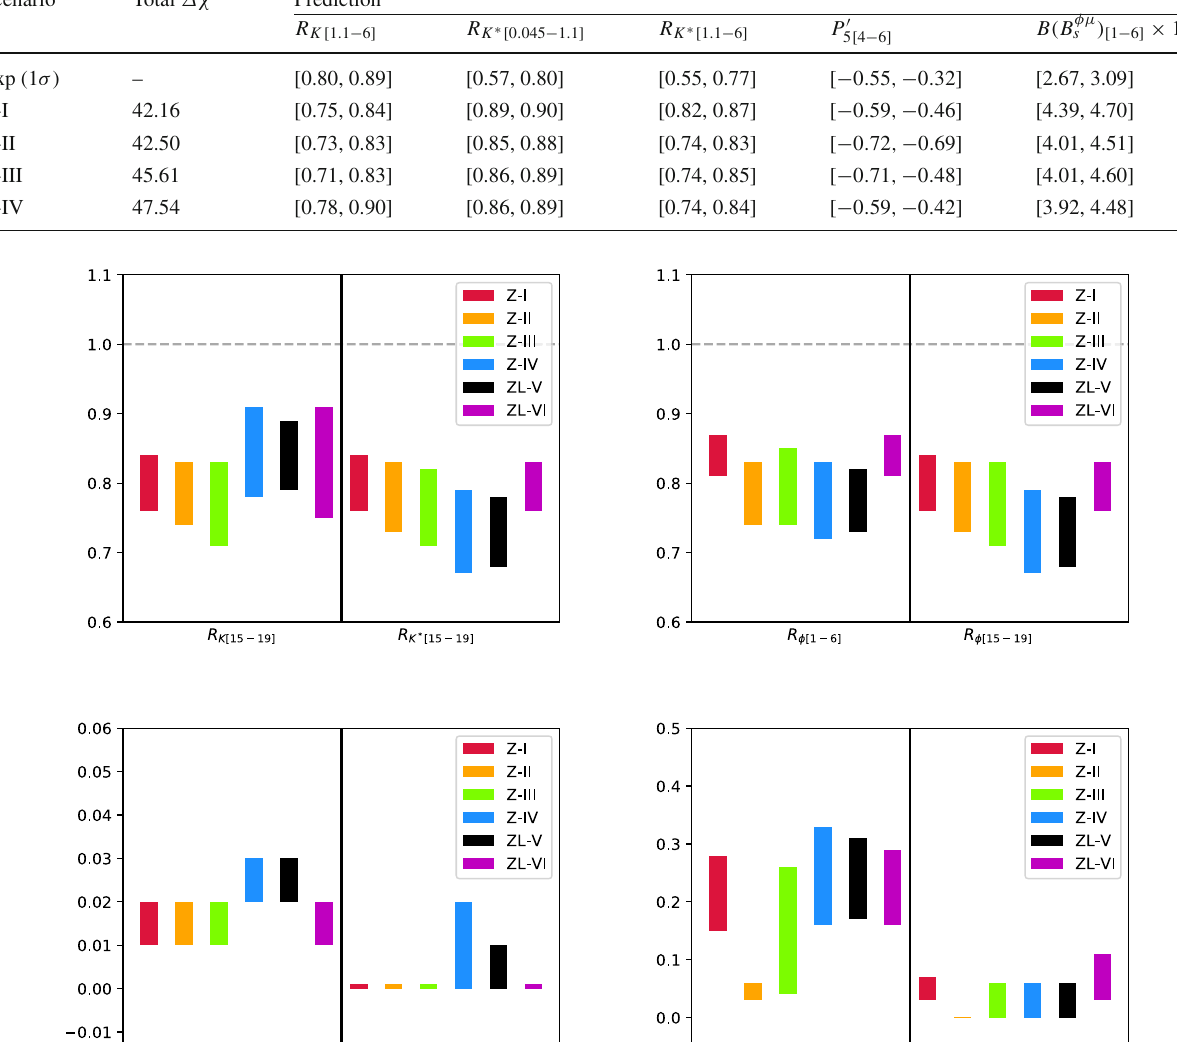
Table 3 Fit results for “1D” and “2D” scenarios generated in heavy Z (cid:4) models and 1 σ ranges of some of the observables used in the fit. Here